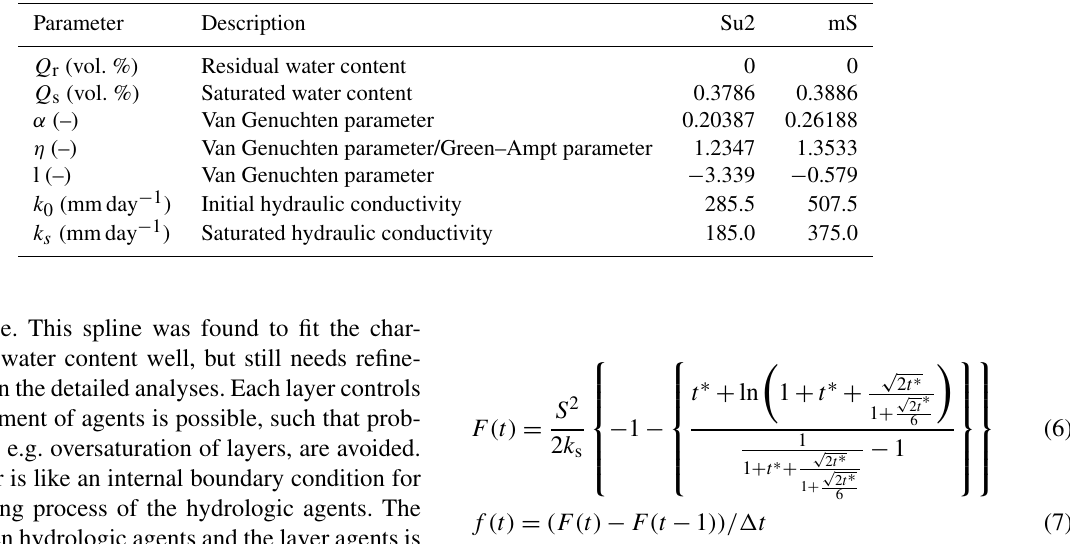
Table 1. Physical soil parameters for the Green–Ampt model and van Genuchten model. Source: DBG Arbeitsgruppe Kennwerte des Bo- dengefüges